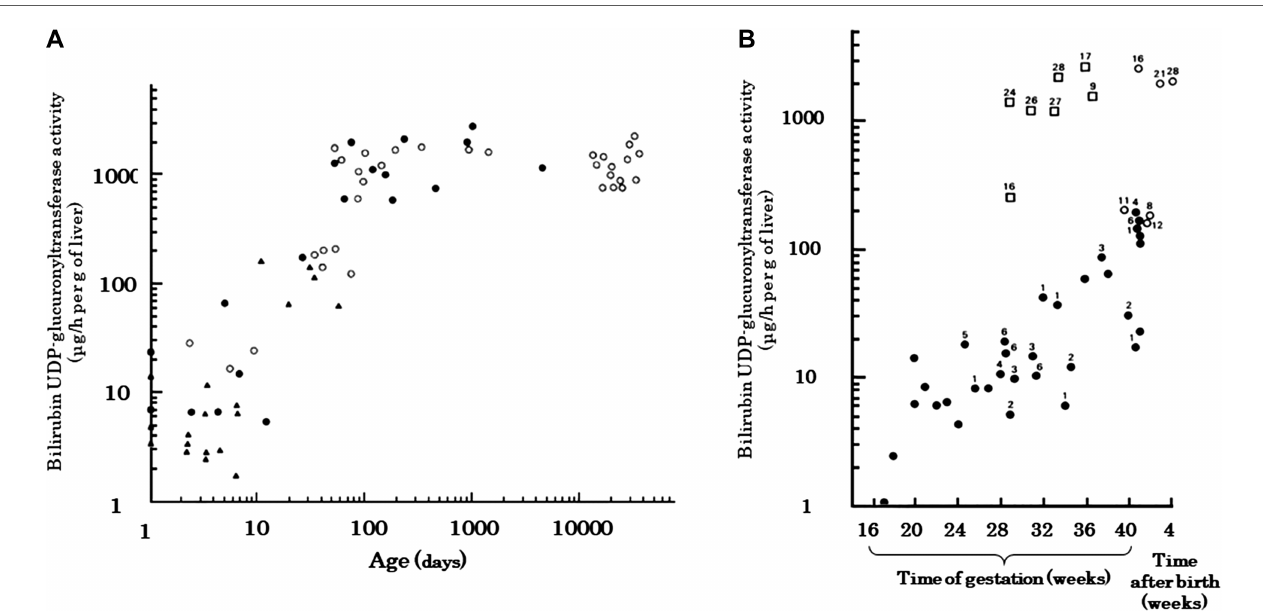
FIGURE 5 Developmental change in human hepatic bilirubin UDP-glucuronosyltransferase activity [adapted from onishi et al. (95) and Kawade and Onishi (68)]. ( A ) Measurements from newborn to adult. Both the ordinate and the abscissa are plotted on logarithmic scales. ● , autopsied cases; ○ , upper abdominal laparotomy; ▴ , preterm neonates. ( B ) Relationship between enzyme activity and survival. Preterm delivery, irrespective of gestational age, evokes an early increase in transferase activities, equal in rate to the normal postnatal increase. The number shown beside the symbols represent the age (days) at which death occurred. Transferase activities are also shown for preterm ( □ ) and term ( ○ ) infants who lived more than 8 days after birth. ● , Transferase activities for fetuses and preterm and term infants who died within 7 days of